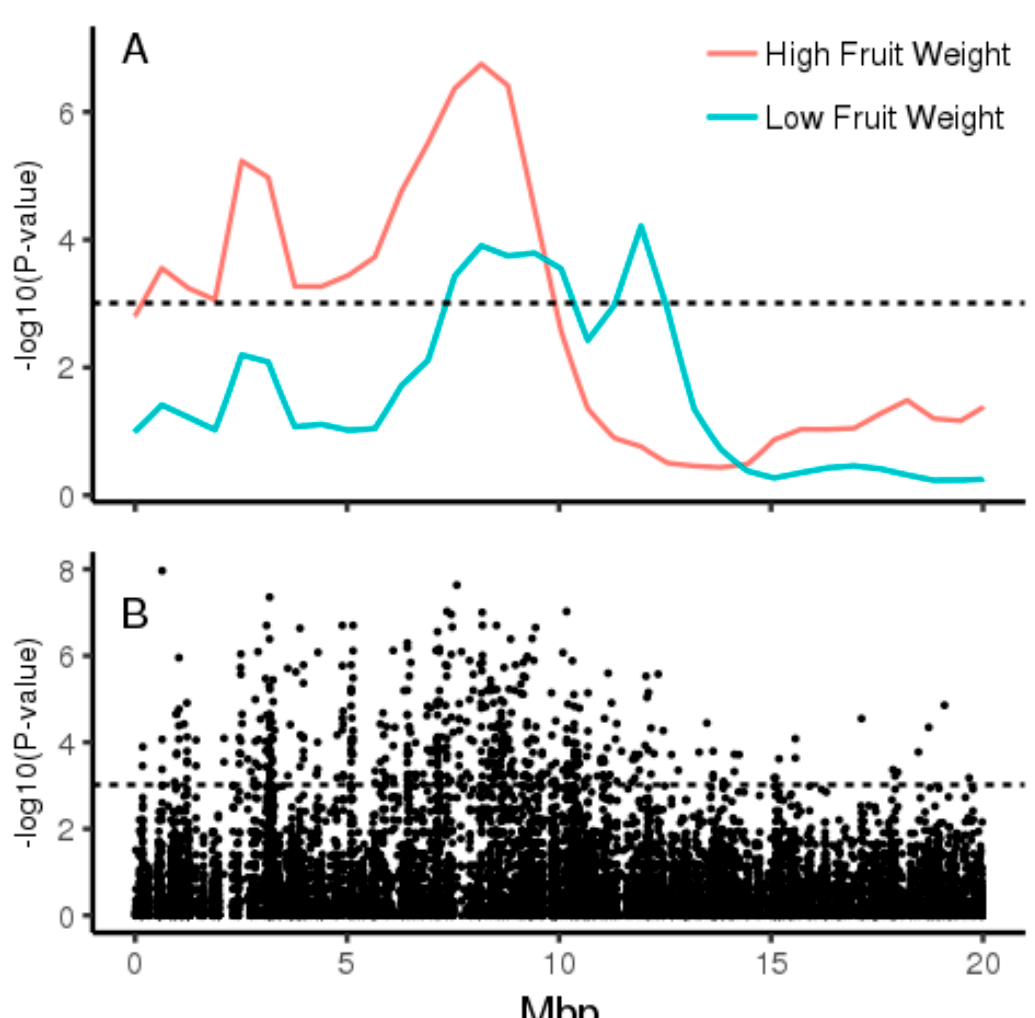
Figure 5. Pool-GWAS analysis of fruit AsA levels on Chromosome 26 using ( A ) 1 Mbp windowed analysis using QTLseqr performed separately in high and low fruit weight pools. ( B ) CMH tests at individual SNPs using Popoolation2. Sites were restricted to fixed variants between A. eriantha and A. chinensis . Dashed lines denote false discovery rate (FDR) cut-off at p < 0.001.